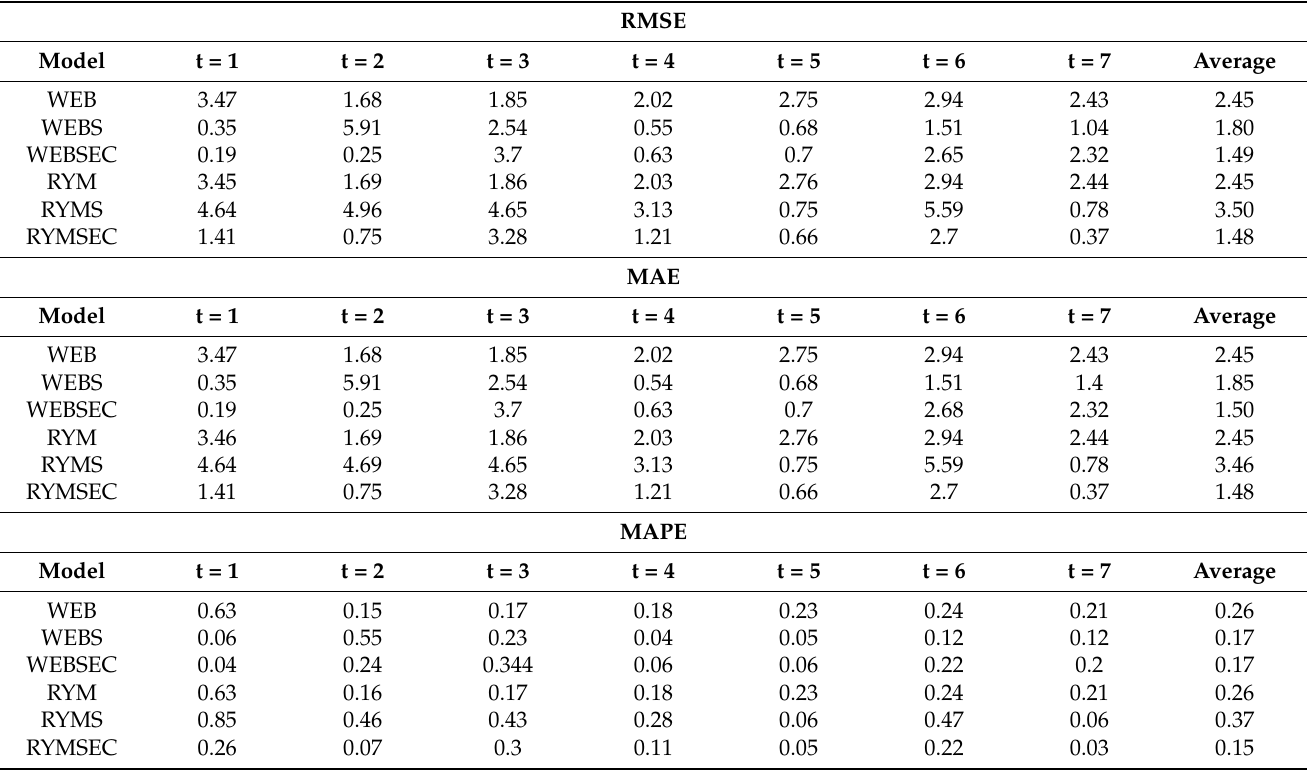
Table 3. Performance results of different WSP models for Southern Offshore TX